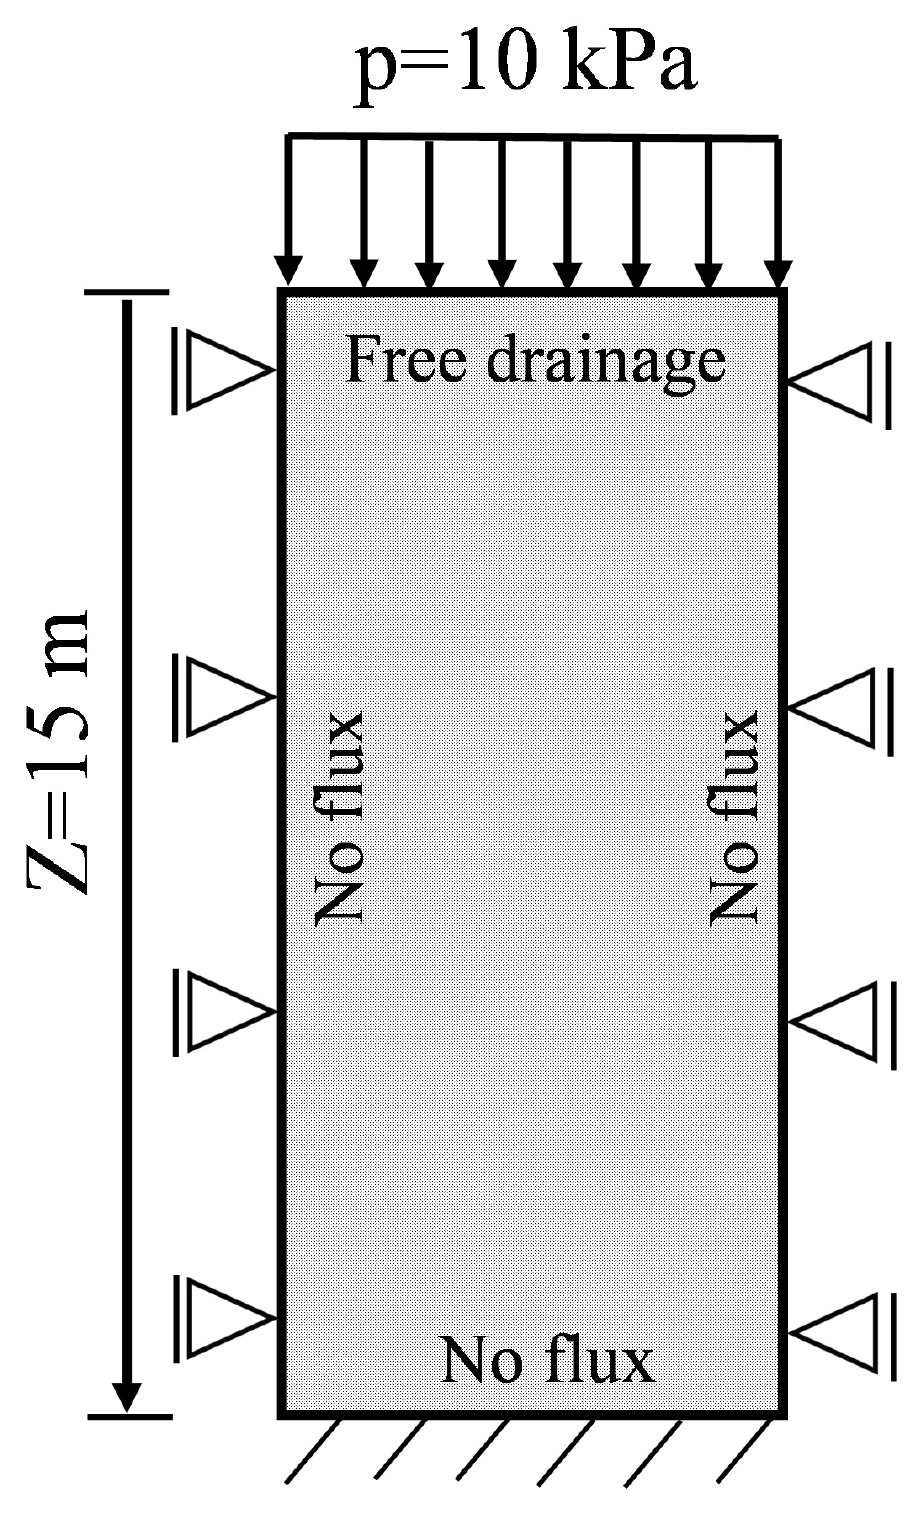
Figure 3. One-dimensional consolidation problem in clay.